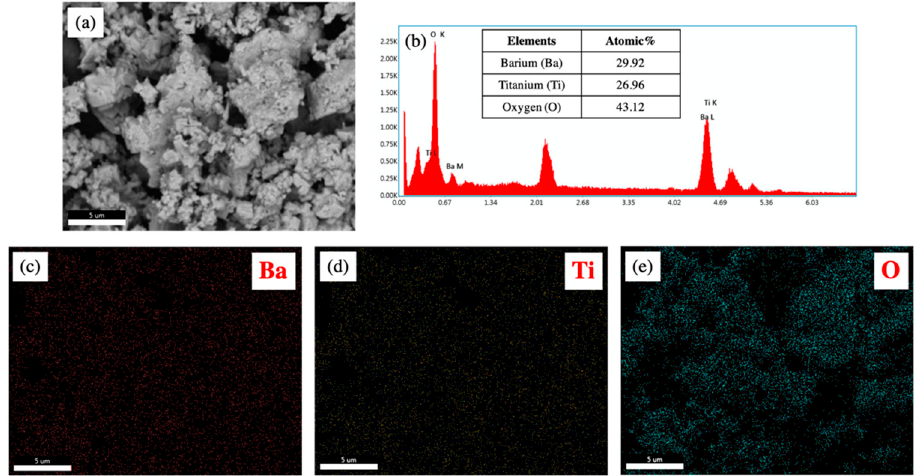
Figure 4. Energy-dispersive X-ray spectroscopy (EDS) results of BaTiO 3 ( a ) SEM image of mapping area, ( b ) EDS spectra, and elemental mapping of ( c ) barium (Ba), ( d ) titanium (Ti), and ( e ) oxygen (O).